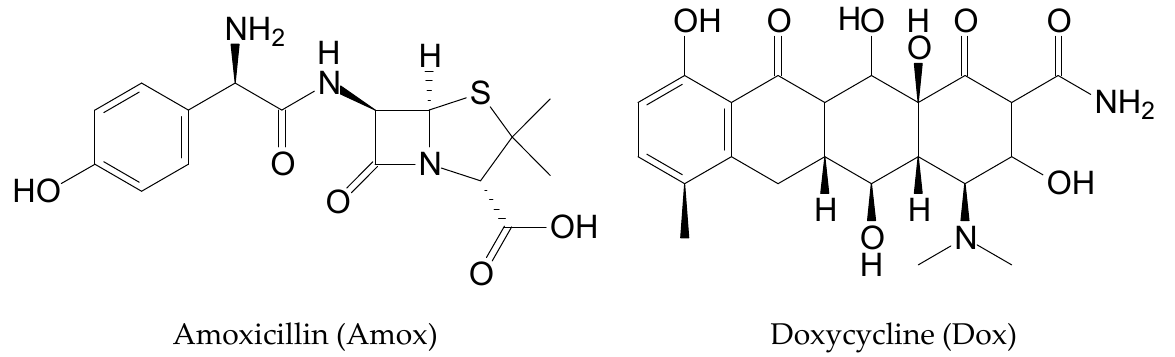
Figure 1. Chemical structure of amoxicillin (Amox) and doxycycline (Dox). The literature depicts various analytical approaches for the quantitative